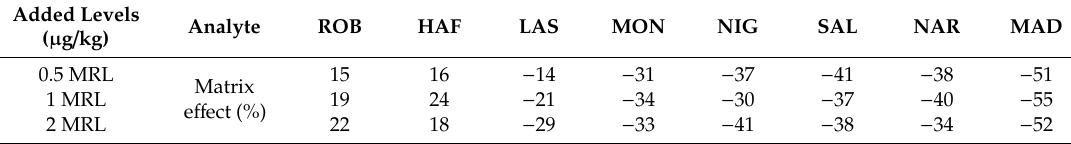
Table5. Matrixe ff ectsoftheeggsamplesoneightcoccidiostatsatthreelevelsinUPLC–MS /